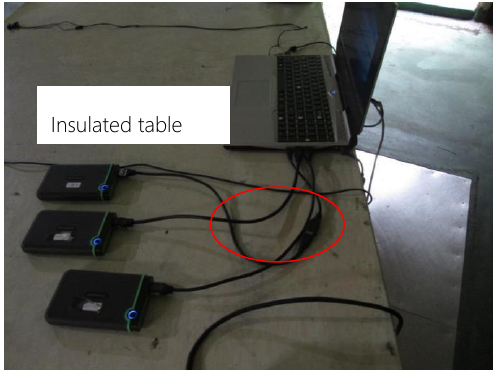
Figure 12. Schematic diagram of staggered wire around the object to be